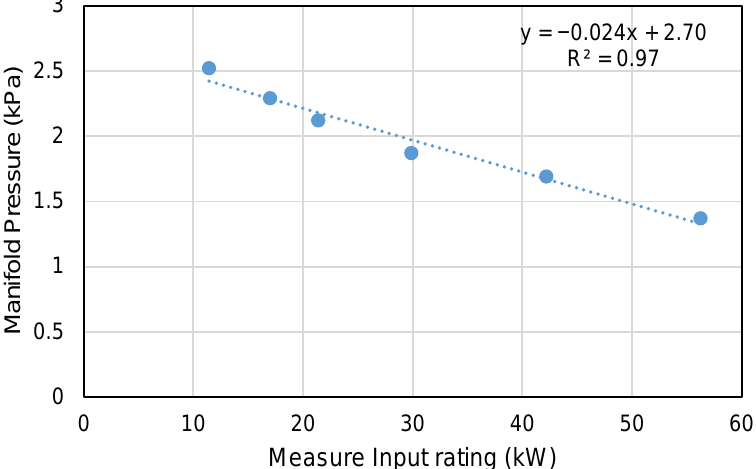
reaching its rated output.